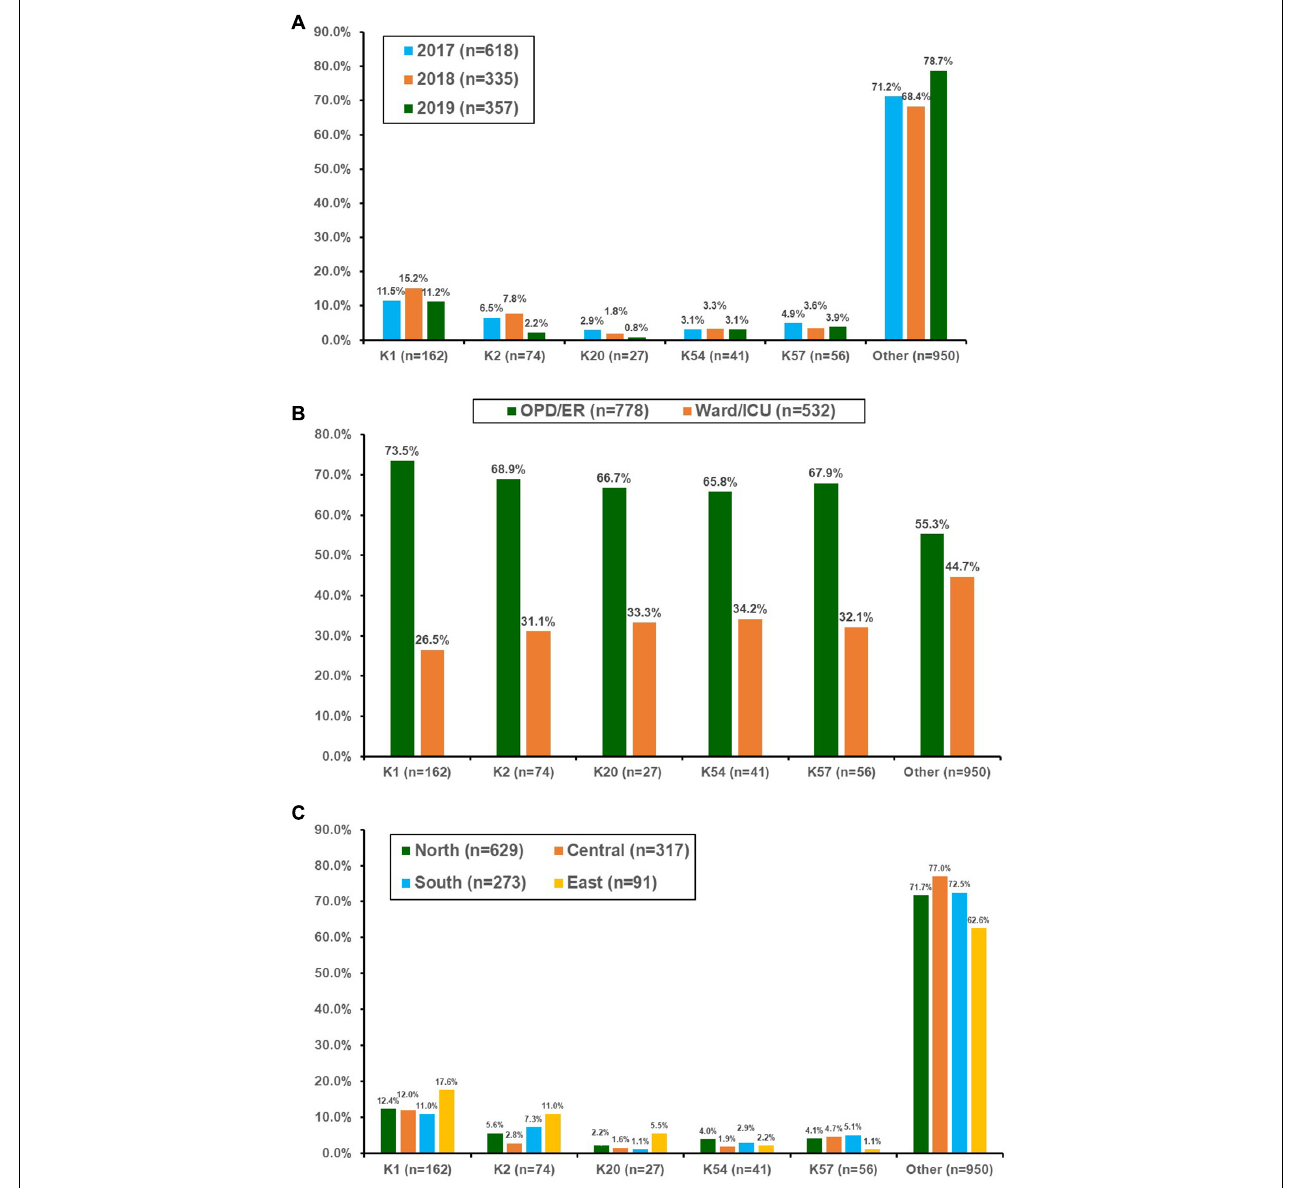
FIGURE 1 | Distribution of the main capsular serotypes of Klebsiella pneumonia isolated from patients with bacteremia who were treated at 16 hospitals in Taiwan between 2017 and 2019. (A) By year, (B) according to location of blood culture collection, and (C) by different geographic regions in Taiwan. OPD, outpatient clinics; ER, emergency departments; ICU, intensive care